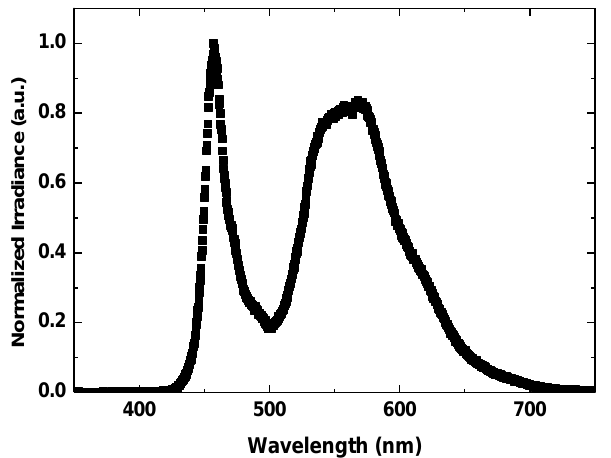
Figure 2. Emission spectrum of a W11492 white